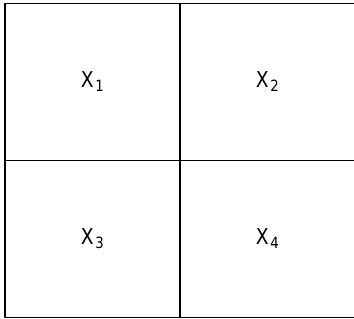
Figure 2. Neighbors of x 1 , x 2 , x 3 and x